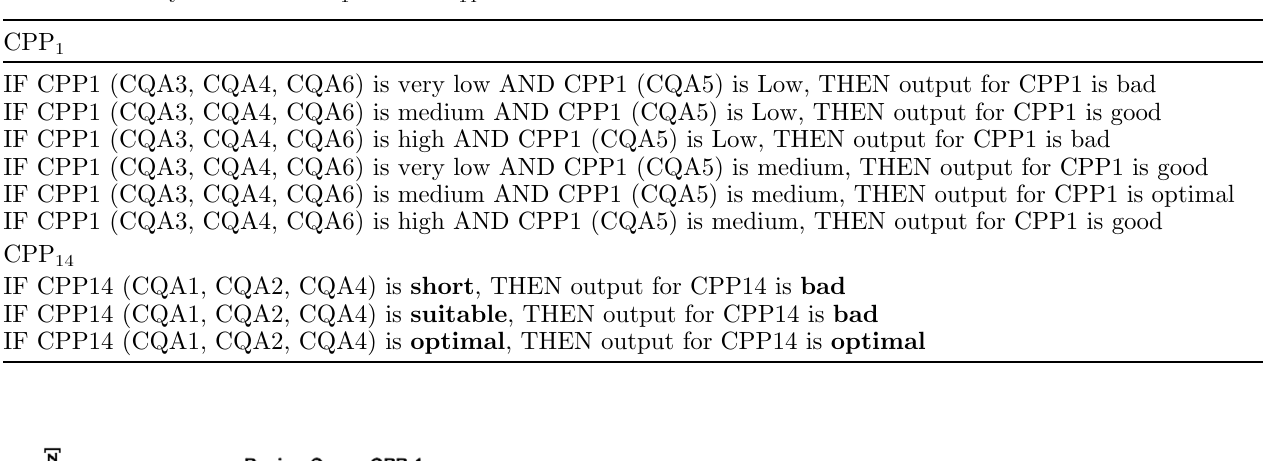
Table 5. Fuzzy rules for CPP